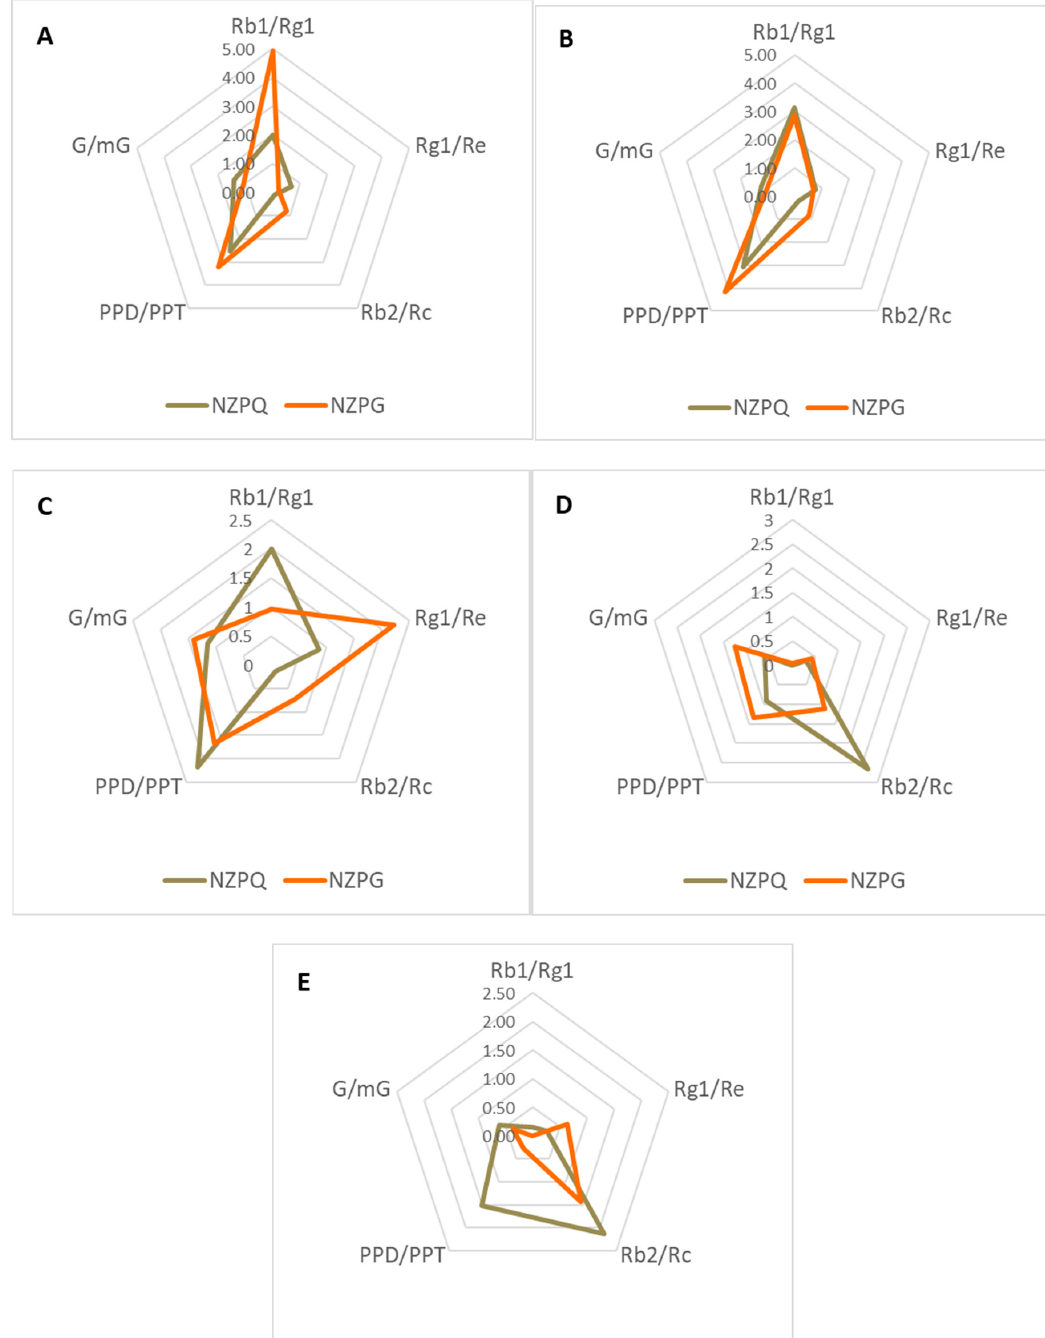
Figure 7. The ratios of Rb1/Rg1, Rg1/Re, Rb2/Rc, protopanaxadiol/protopanaxatriol (PPD/PPT), and G/mG in NZPQ and NZPG. ( A ) Fine root; ( B ) rhizome; ( C ) main root; ( D ) leaf; ( E ) stem. The PPD-type amount and PPT-type amounts are the sum of all the quantified PPD-type ginsenosides and PPT-type ginsenosides, respectively. G/mG is the ratio of neutral ginsenoside amount to malonyl ginsenoside amount; the malonyl ginsenoside amount is the sum of five quantified malonyl ginsenosides (mRb1, mRb2, mRb3, mRc, and mRd), and the neutral ginsenoside amount is the sum of corresponding neutral ginsenosides (Rb1, Rb2, Rb3, Rc, and Rd).